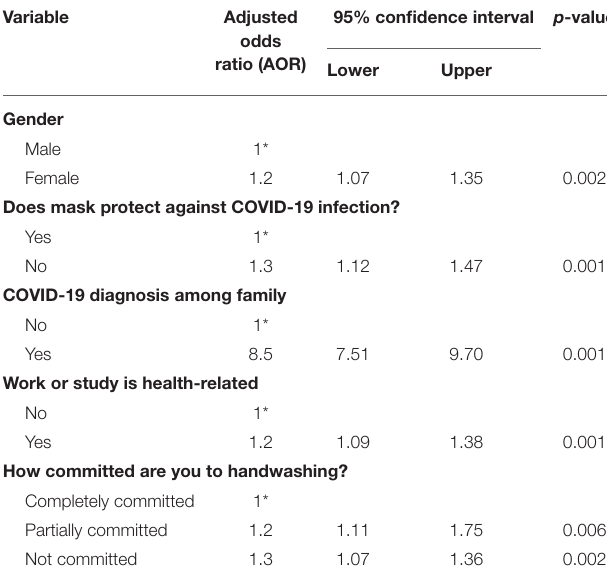
TABLE 4 | Logistic regression analysis of factors associated with an increased odd of contracting COVID-19.